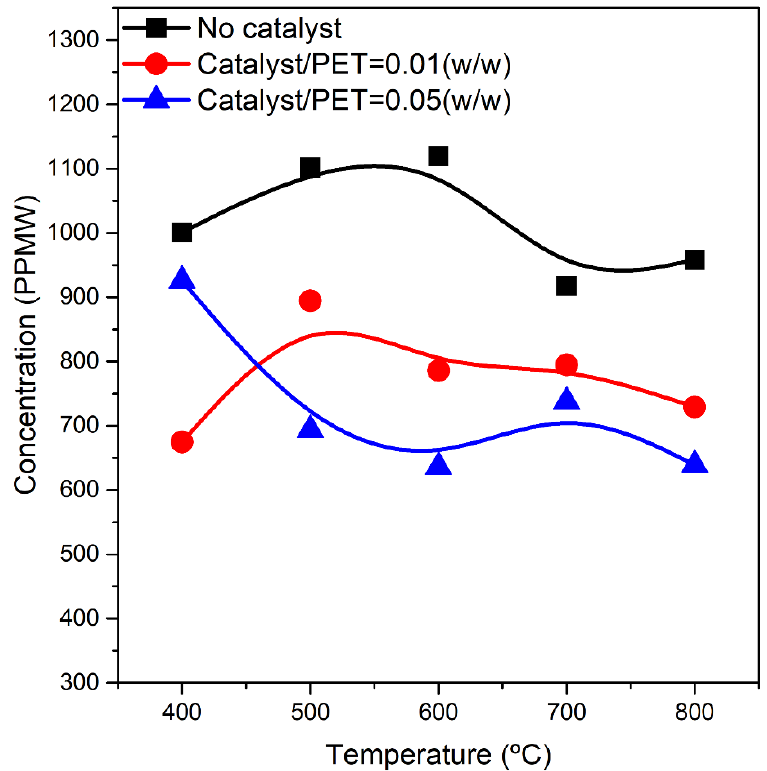
Figure 2. Concentration of the total amine derivatives from the pyrolysis of PET with and without Pd catalyst as a function of the temperature.